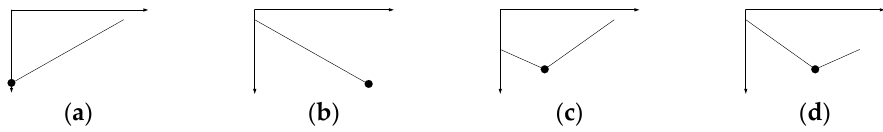
Figure A4. dist ( o , p ) × CI ( Q , p ) graphs for Case 3: ( a ) case 3.1, ( b ) case 3.2, ( c ) case 3.3, and ( d ) case 3.4. In Case 3.1, highDist ( G i , p ) is a non-negative number greater than or equal to the distance from p to any given vertex in G i ; thus, highDist ( G i , p ) ≥ y l , which means that highDist ( G i , p ) ≥ dist ( o , p ). Because CI ( Q , p ) < 0, LB ( G i , p ) = CI ( Q , p ) × ( highDist ( G i , p ) + maxEdge ( G i )/2) ≤ CI ( Q , p ) × highDist ( G i , p ) ≤ CI ( Q , p ) × dist ( o , p ). In Case 3.2, highDist ( G i , p ) is a non-negative number greater than or equal to the distance from p to any given vertex in G i ; thus, highDist ( G i , p ) ≥ y r , which means that highDist ( G i , p ) ≥ dist ( o , p ). Because CI ( Q , p ) < 0, LB ( G i , p ) = CI ( Q , p ) × ( highDist ( G i , p ) + maxEdge ( G i )/2) ≤ CI ( Q , p ) × highDist ( G i , p ) ≤ CI ( Q , p ) × dist ( o , p